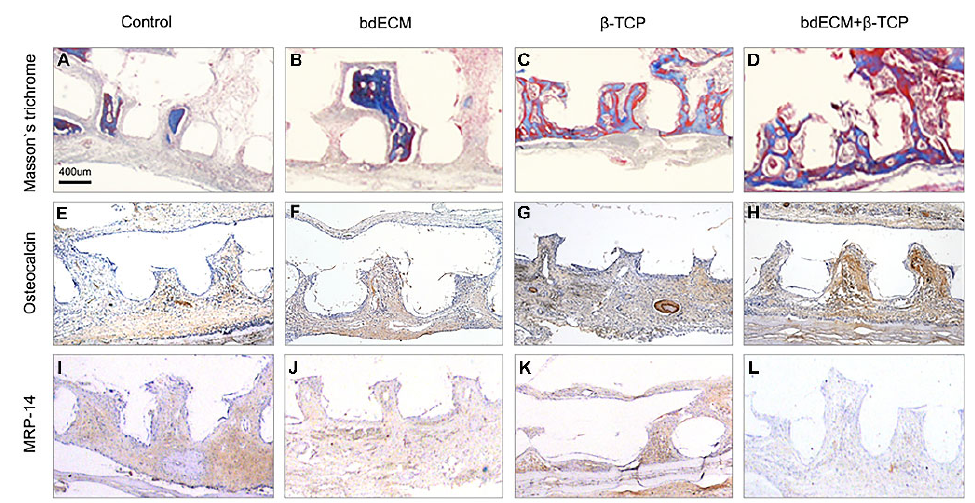
Figure 4. Histological analysis of animal defect area. ( A – D ). Masson’s trichrome staining showed blue staining on the cross-section of the scaffold. A strong blue positive area was most frequently observed in the mixed material (bdECM + β -TCP) ( D ); ( E – H ). In osteocalcin immunohistochemistry analysis, brown positive cells were most frequently observed in the group of bdECM + β -TCP ( H ); ( I – L ). MRP-14 immunohistochemistry showed unusual macrophage cell distribution, with bdECM and mixture groups showing reduced macrophage distribution ( L ).